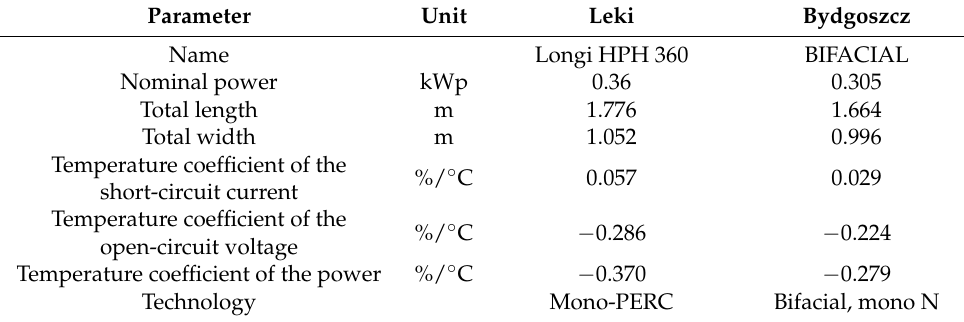
Table 1. Characteristics of PV panels. Source: own study based on [48,49]. Parameter